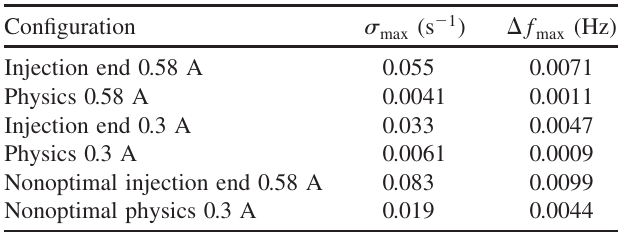
TABLE IV. Growth rates of the most unstable mode and maximum tune shifts for each configuration, with the 1-Turn feedback on.